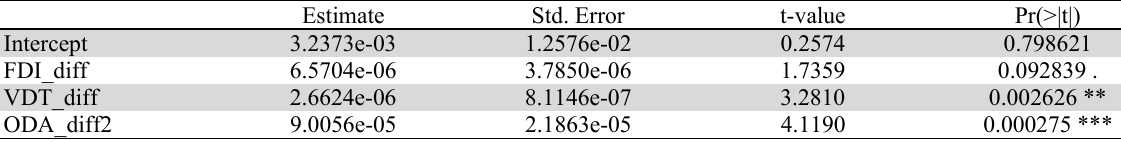
Regression model after fixing defects (T test of coefficients) Estimate Std.